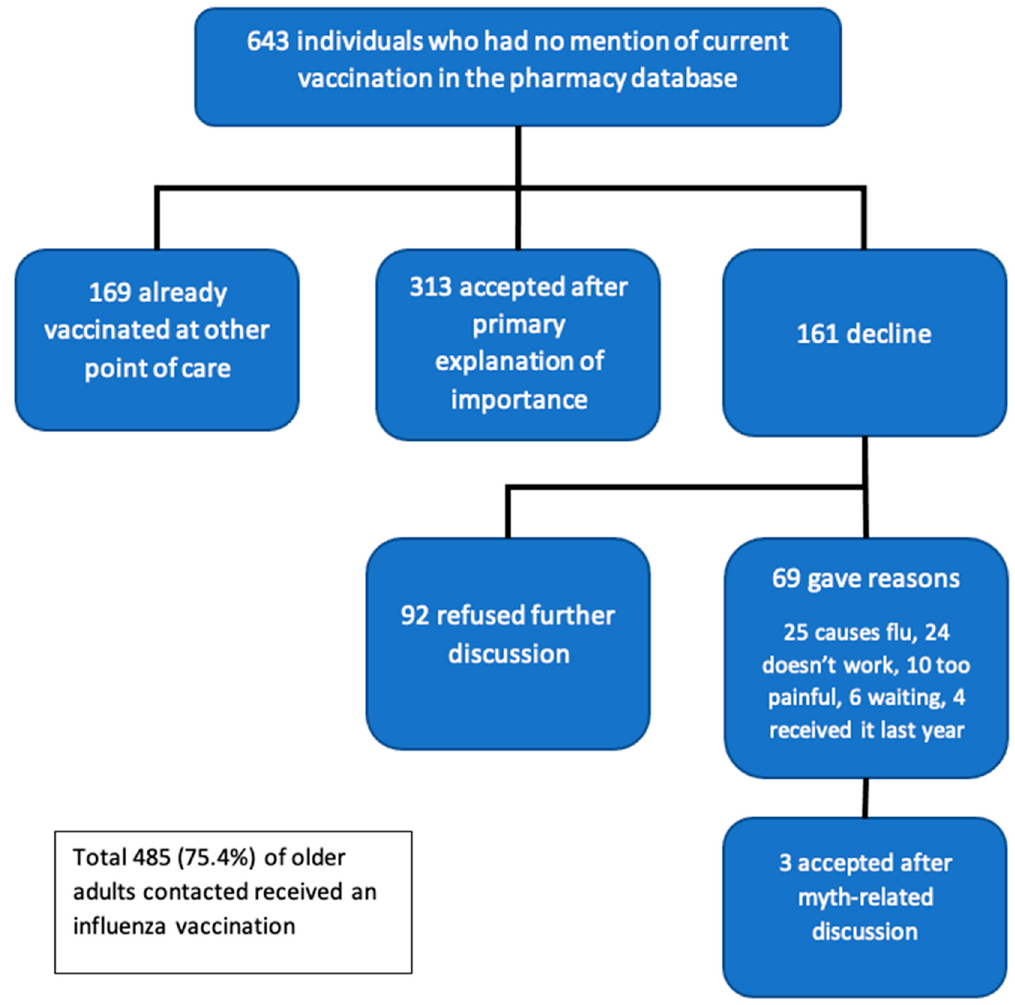
Figure 2. Patient pathway in the quality improvement project.